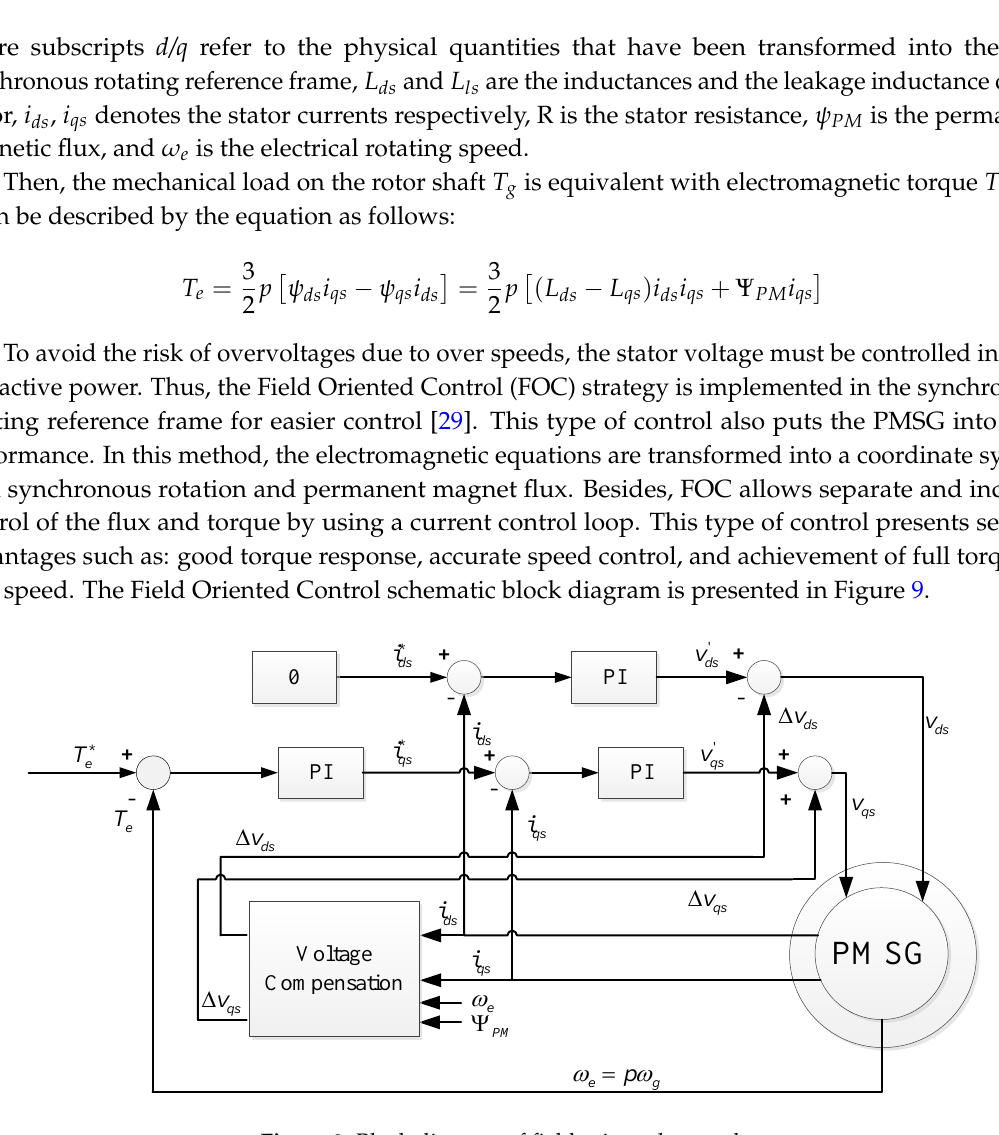
Figure 9. Block diagram of field oriented control.